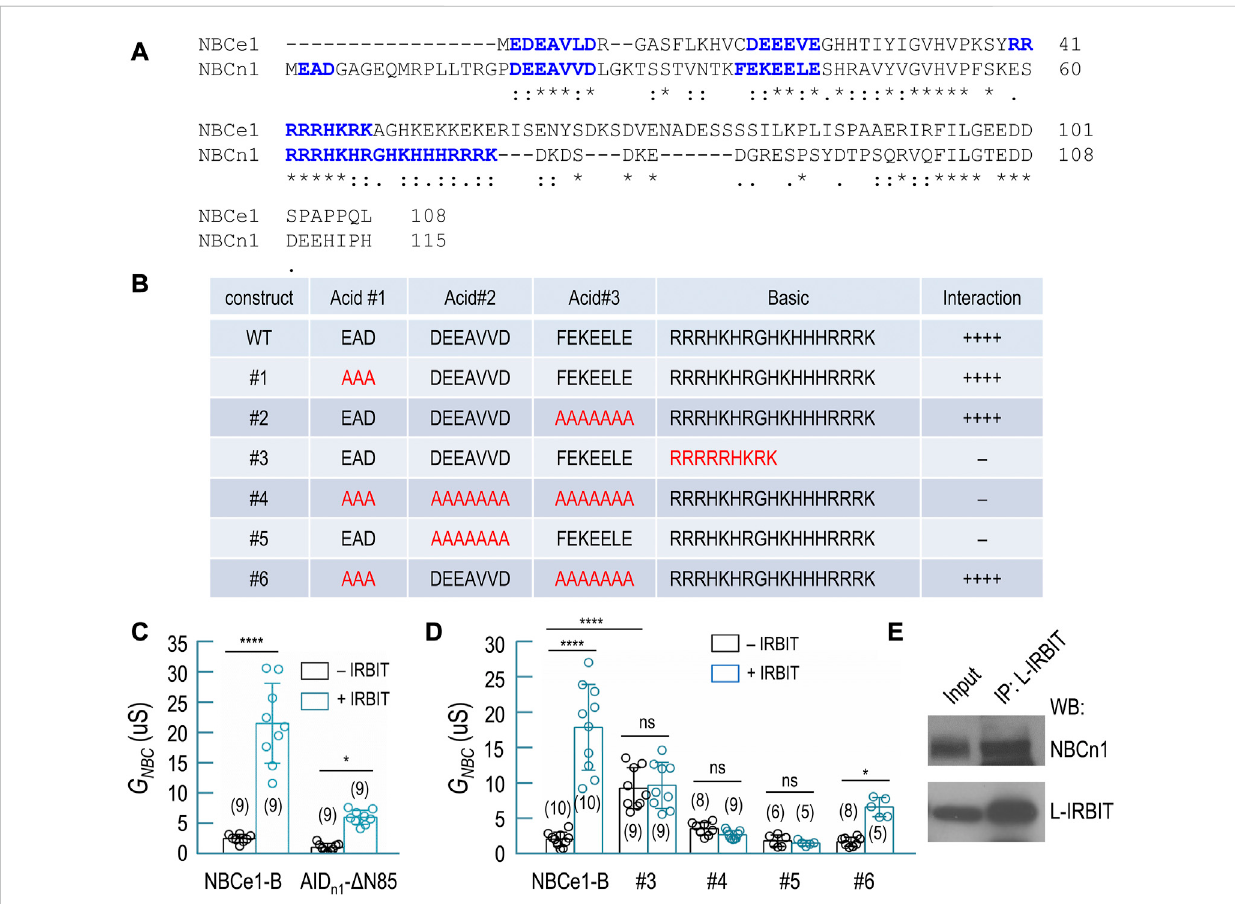
FIGURE 7 Interactionof IRBIT andL-IRBIT with NBCn1. (A) Alignmentoftheinitial Nt ofNBCn1 with theunique Ntof NBCe1(variant B). (B) Characterization of structural elements of NBCn1 essential for binding of IRBIT by yeast-2-hybrid assay. (C) Summary for the effect of the auto-inhibition domain of NBCn1 (residues 1 – 115) on transport activity of NBCe1. (D) Summary for the transport activity of NBCe1 containing variants of AID of NBCn1. (E) Co- immunoprecipitation analysis showing the interaction of NBCn1 with L-IRBIT in rat kidney. In Panels (C,D) , data are presented in mean ± S.D. in Panels (C,D) . The numerals in the parentheses indicate the number of individual oocytes included in each bars. For statistical analysis, one-way ANOVA followed by Tukey ’ s comparison was performed. * p < 0.05; **** p < 0.001. ns: not signi fi